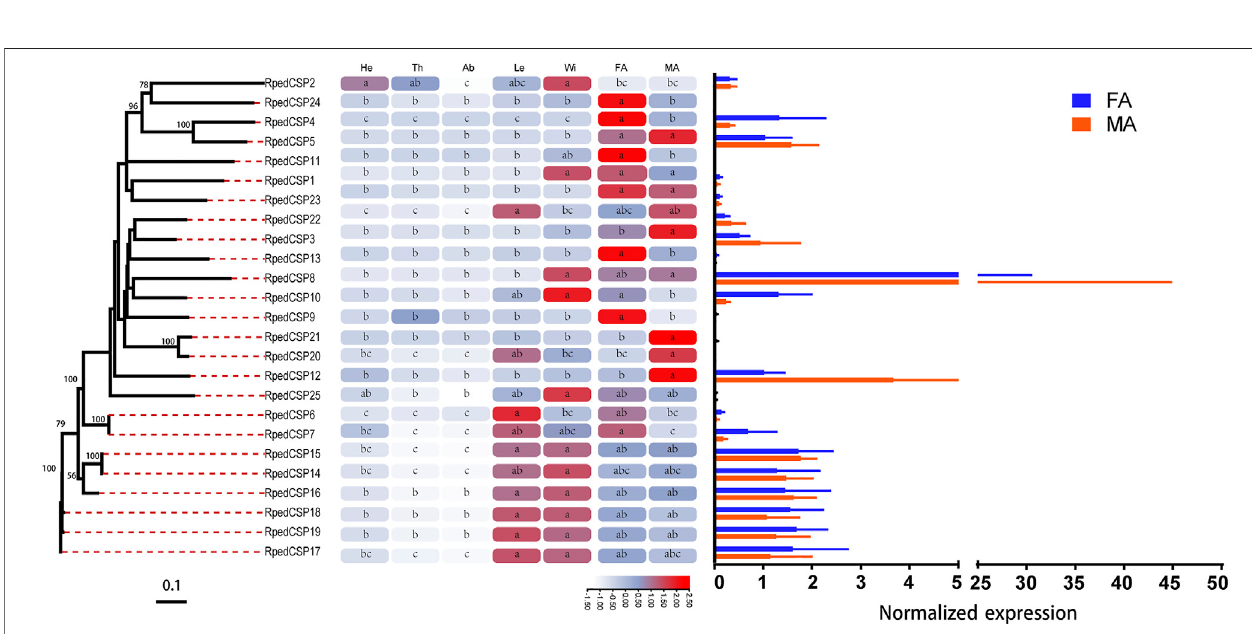
Frontiers in Physiology |